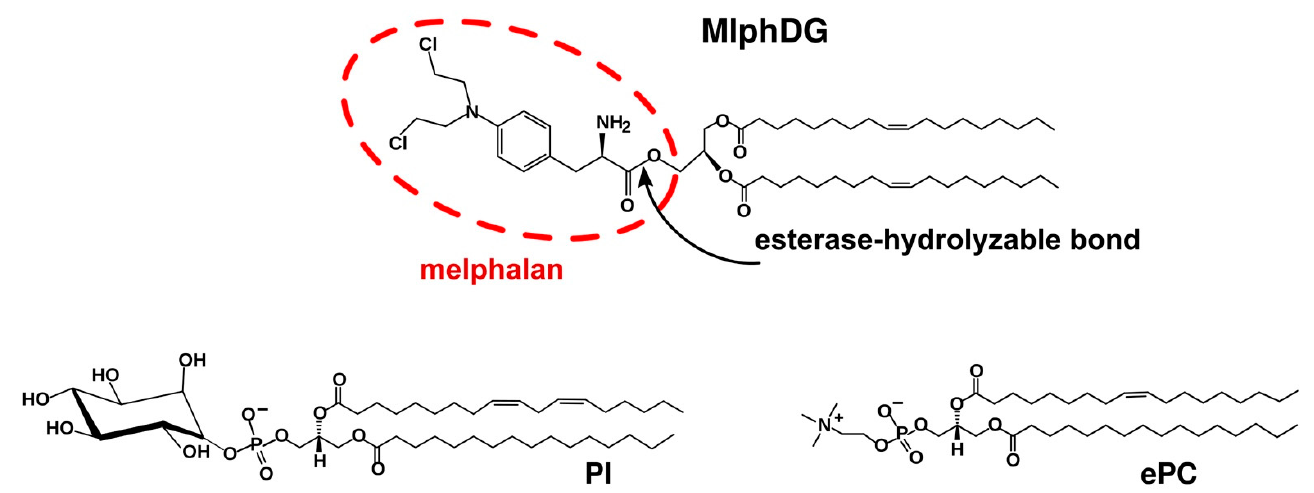
Figure 1. Structure of melphalan lipophilic prodrug (MlphDG) and representative structures of soybean phosphatidylinositol (PI) and egg phosphatidylcholine (ePC) used for liposome preparation.